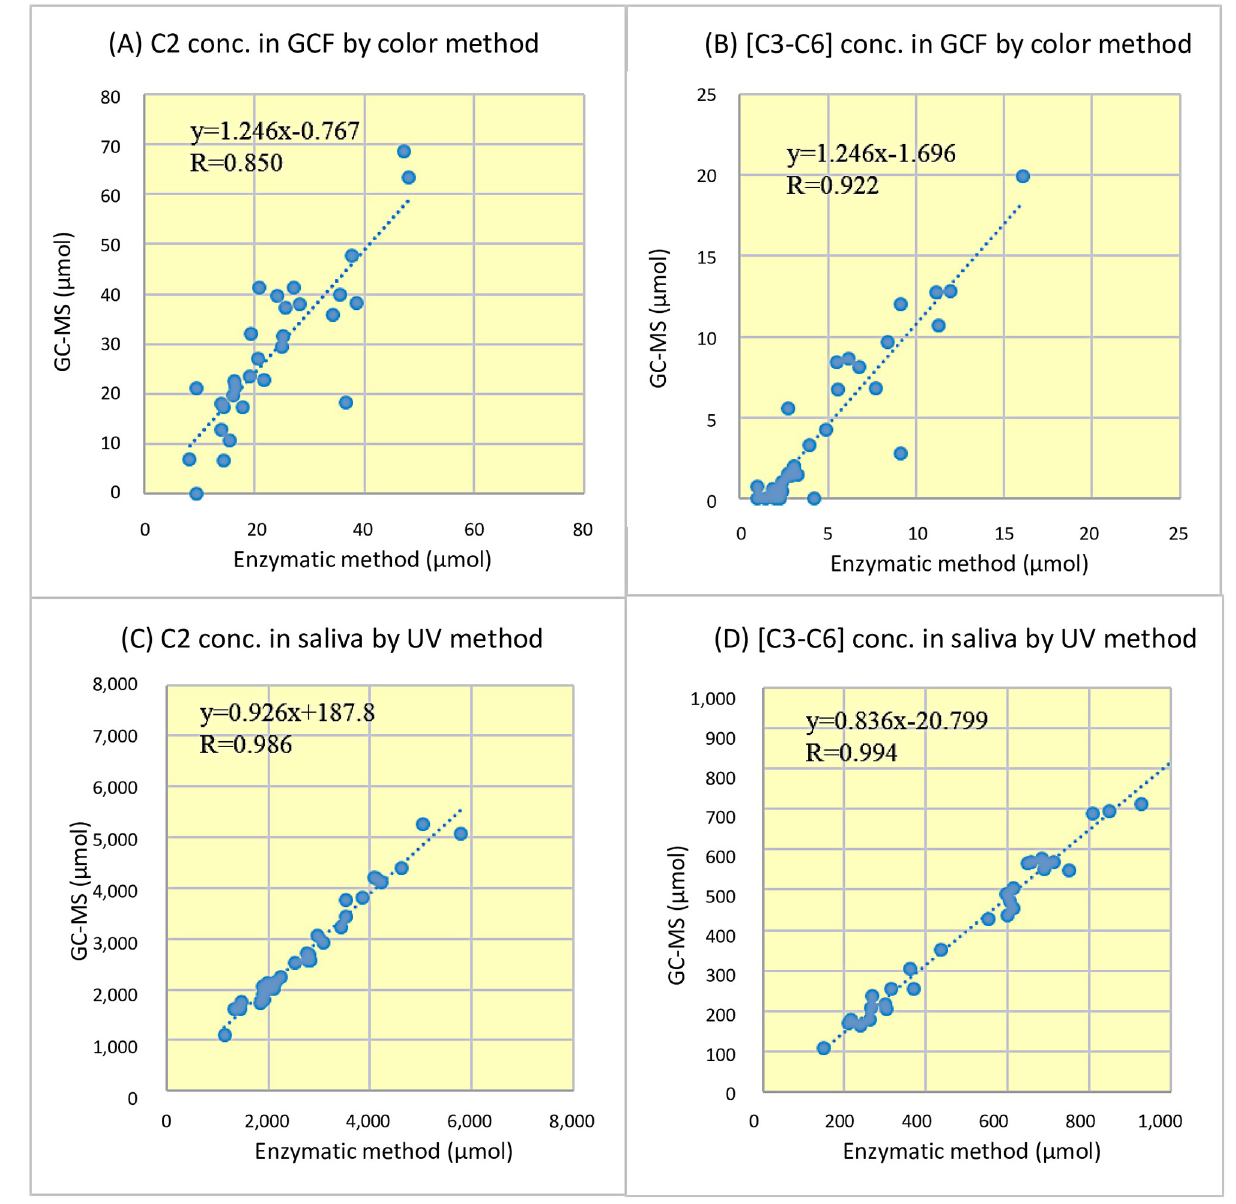
Fig 2. Correlation between the enzymatic method and GC–MS method for the measurement of C2 and [C3–C6] in the GCF and saliva. (A) C2 and (B) [C3-C6] in the GCF were measured using the color method of the enzymatic method. (C) C2 and (D) [C3-C6] in the saliva were measured using the ultraviolet rays method of the enzymatic method. C2, acetic acid; [C3–C6], propionic acid, butyric acid, isobutyric acid, valeric acid, isovaleric acid, and caproic acid; GCF, gingival crevicular fluid; GC–MS, conventional gas chromatography-mass spectrometry.